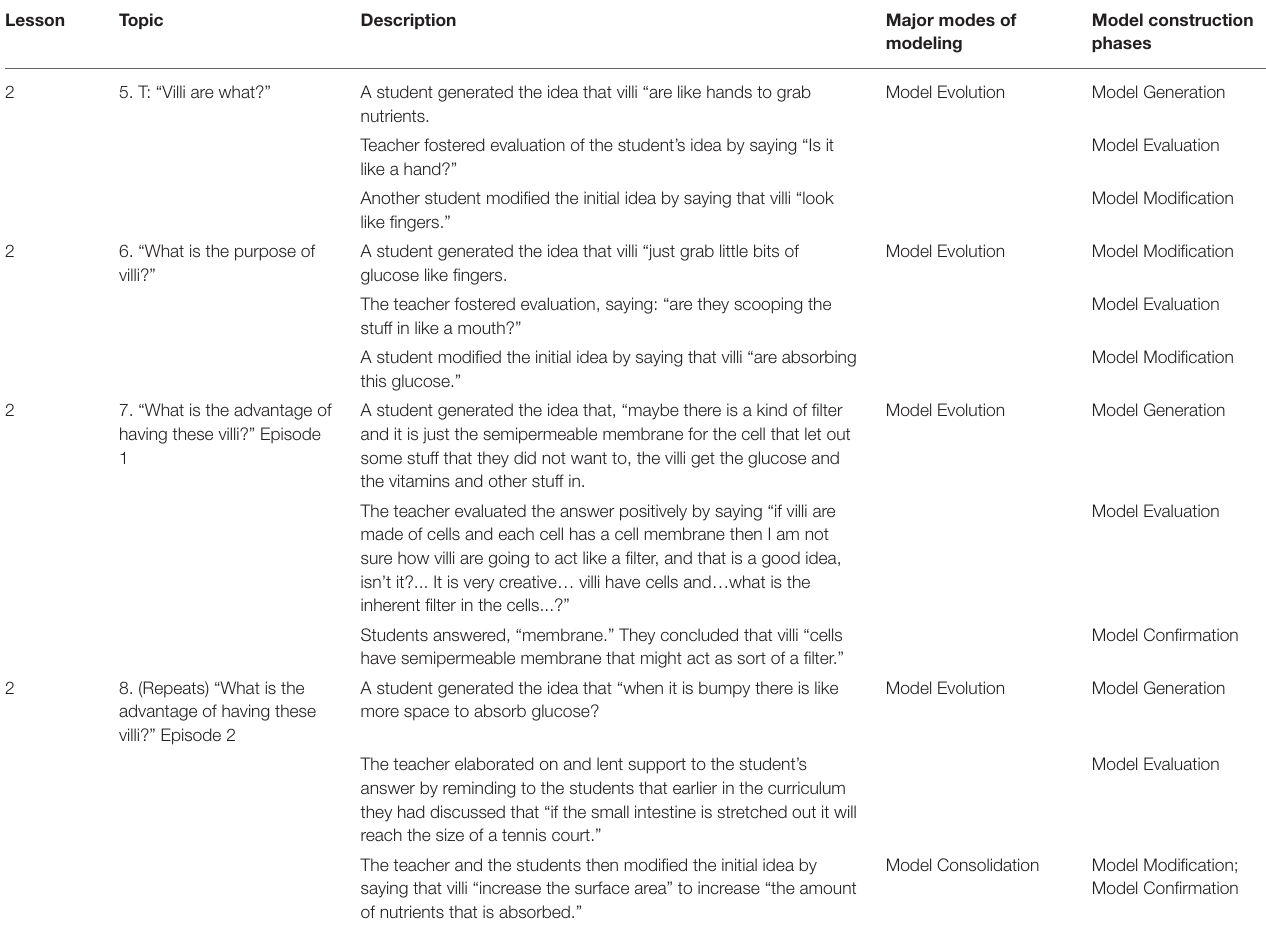
TABLE 4 | Model evolution and consolidation modes (part 2).